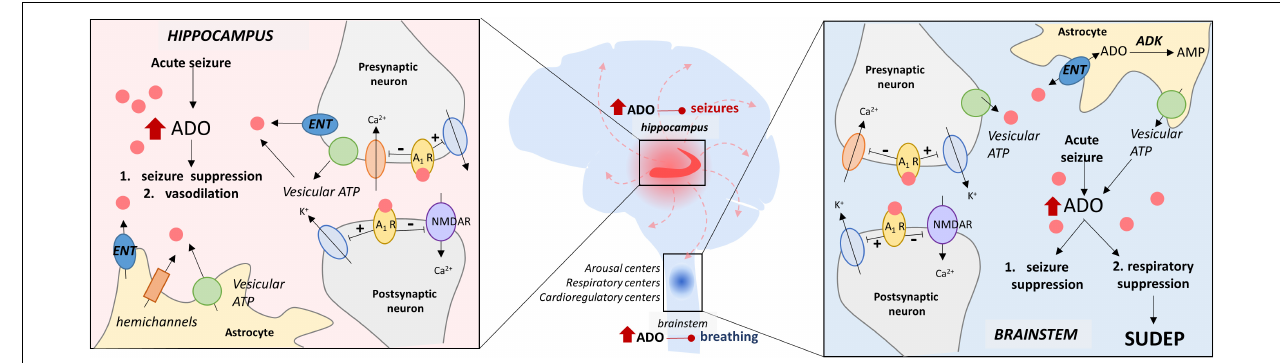
FIGURE 1 | The adenosine hypothesis of SUDEP. This schematic illustrates the hypothesized similarities and differences in periictal adenosine surging and its effects in the hippocampus and the brainstem. In the hippocampus, the ADO surge is important for seizure termination and vasodilation, whereas, in the brainstem, the ADO surge is double-edged and can suppress respiration/breathing in addition to seizure suppression. The key elements of ADO signaling depicted here include (i) vesicular ATP, (ii) equilibrative nucleoside transporters (ENT), (iii) adenosine kinase (ADK), (iv) adenosine receptor (A 1 R), and (v) N-methyl D-aspartate receptors